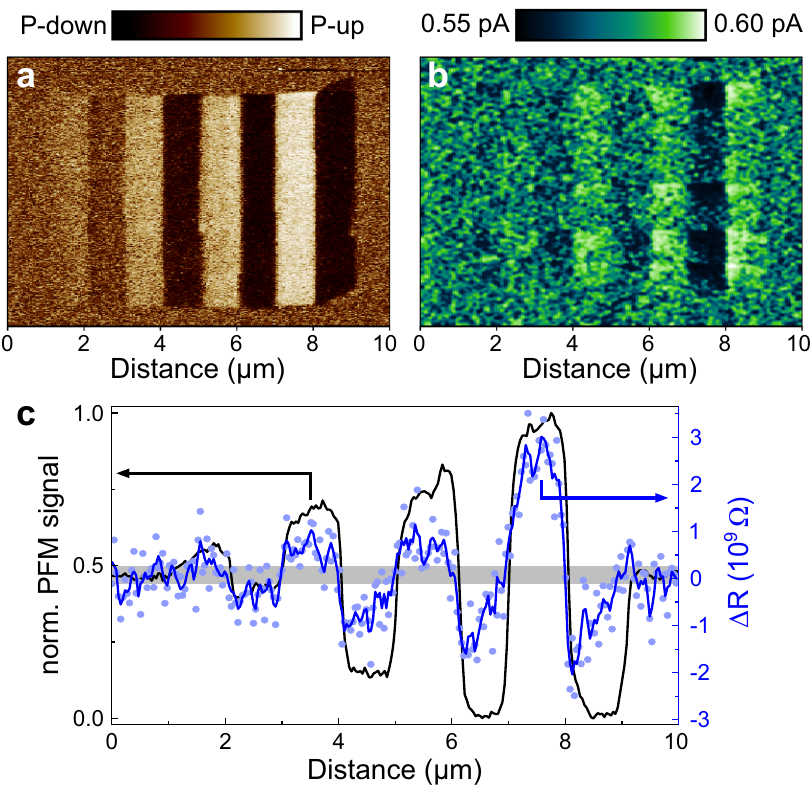
Fig. 4 Variable electroresistance in ultrathin PZT MPB fi lms. a The vPFM image on a 4 nm PZT MPB fi lm displays a gradual polarization switching. b Conductive atomic force microscopy map on the same area as in a with a 100 mV DC reading voltage. c Averaged vPFM signal (black) and resistance change (blue) cross-sections across the poled stripes in a , b , respectively. The blue line shows the three-point moving average of the blue data points. The gray line serves as a guide to the eye to show the PFM signal and resistance of the as-grown